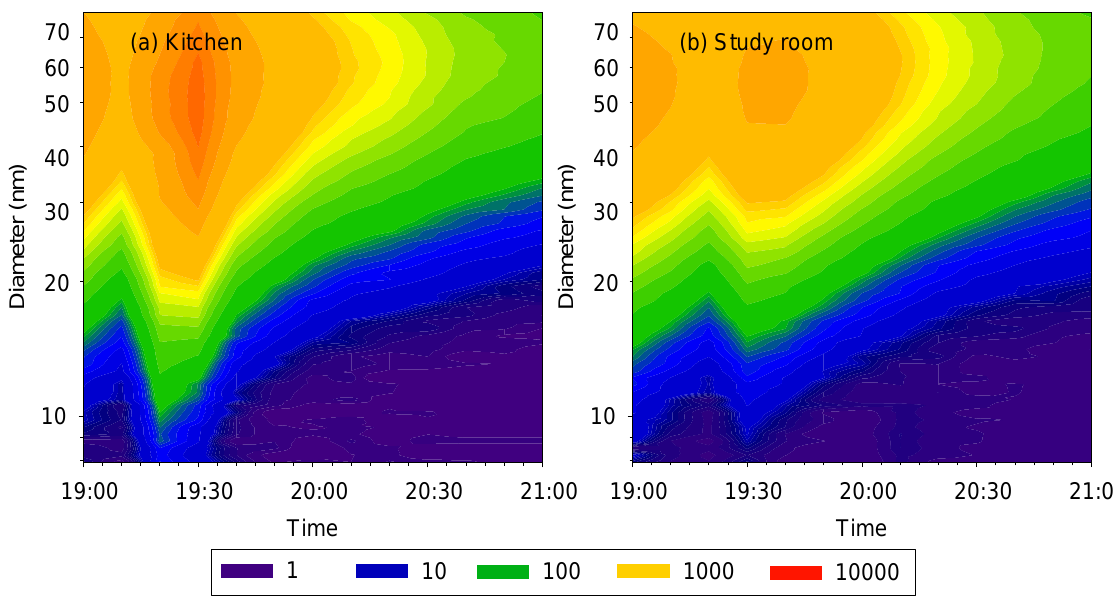
Figure 6. Contour plots of ultrafine particle number size distribution during a cooking episode in (a) the kitchen and (b) the study